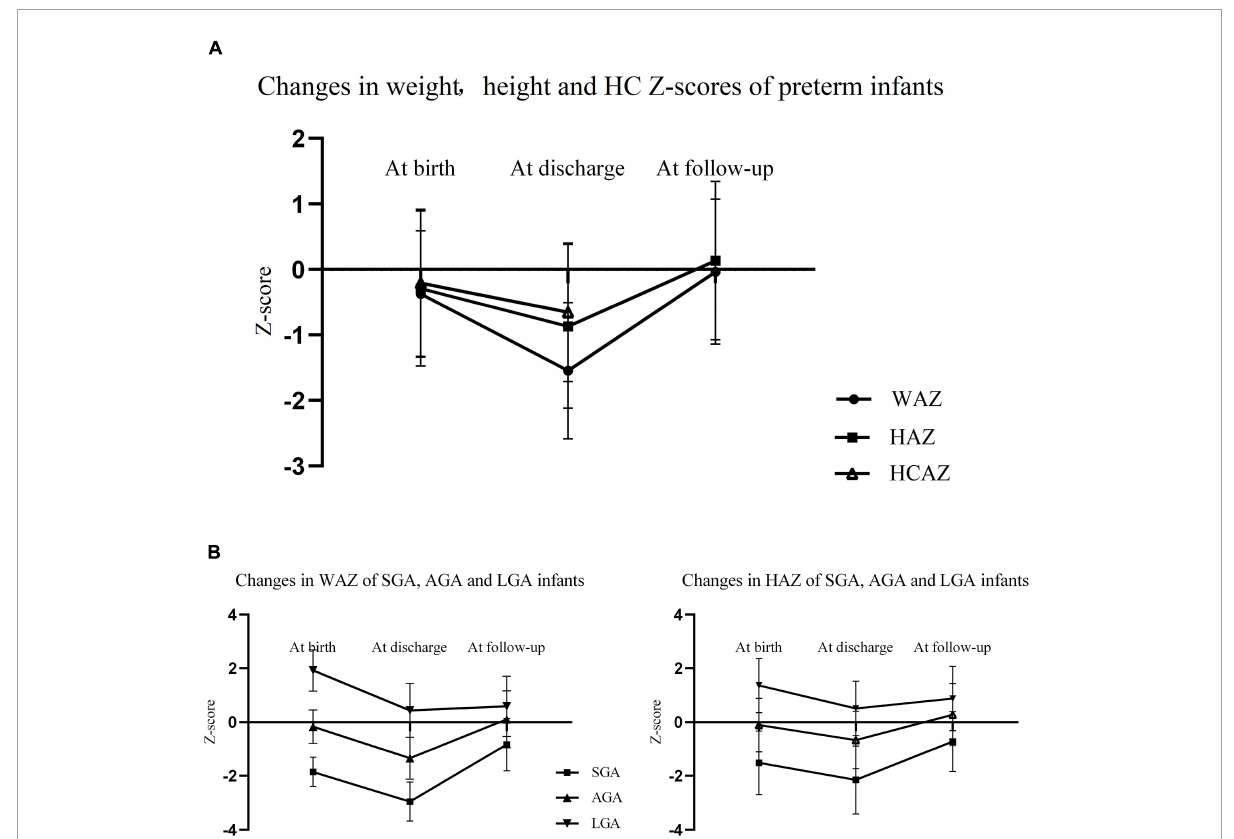
FIGURE3 (A) Changes in WAZ, HAZ, and HCAZ from birth to age 3–6 years of preterm infants (the measurement of HC was not applicable for children at age 3 − 6 years); (B) changes in WAZ and HAZ from birth to age 3 − 6 years of SGA, AGA, and LGA preterm infants. WAZ, weight-for-age Z −